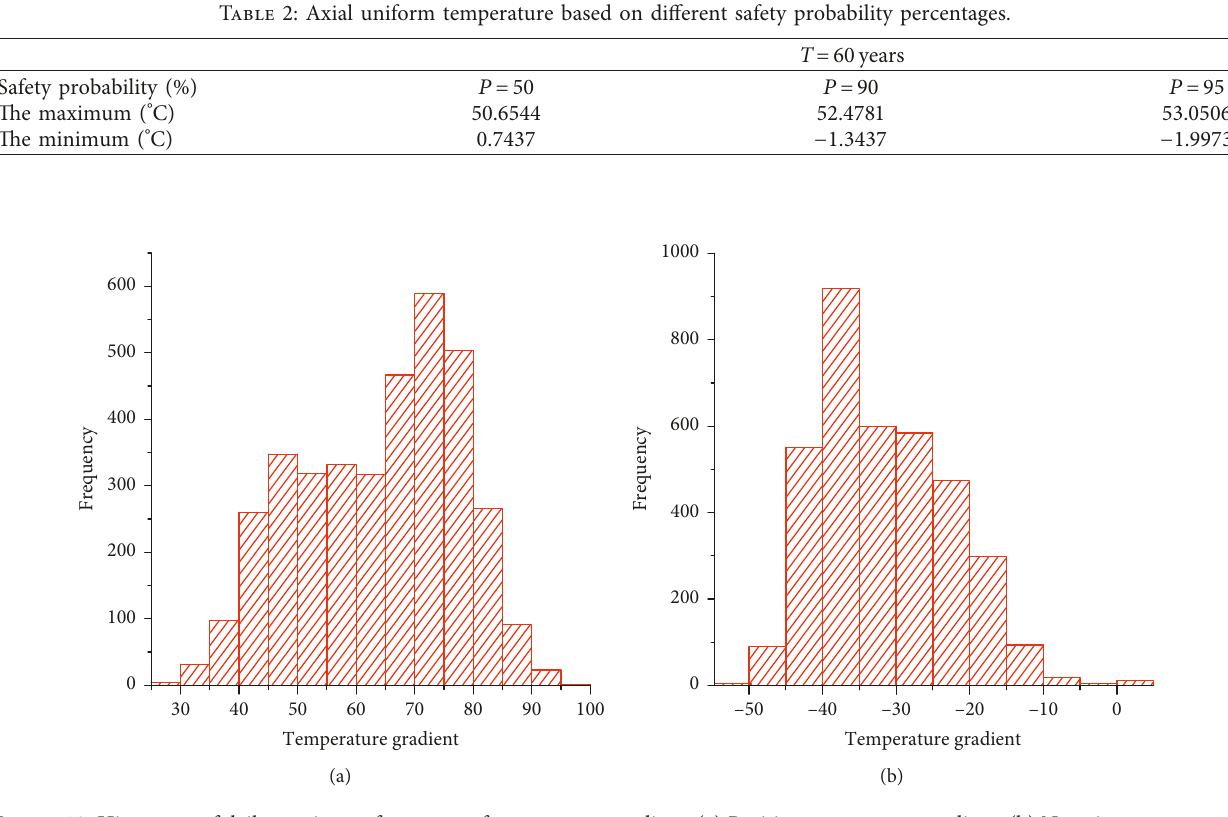
Figure 10: Histogram of daily maximum frequency of temperature gradient. (a) Positive temperature gradient. (b) Negative temperature gradient.